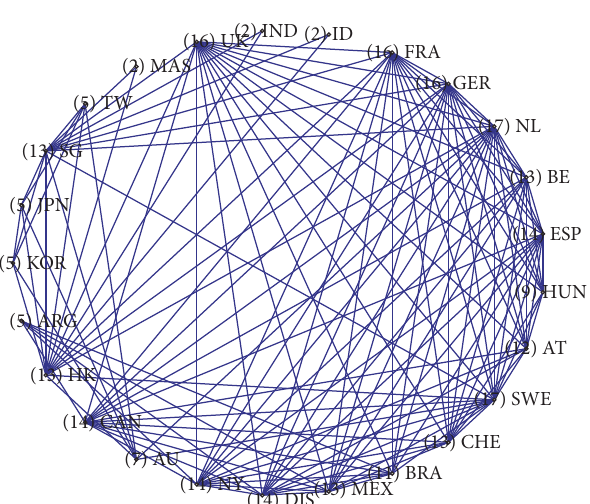
Figure 7: Topology graph of ISMN at 𝜃 = 0.4 .